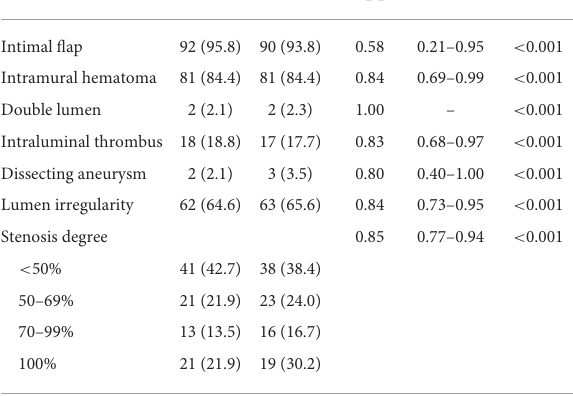
TABLE 3 The agreement between CDU and hrMRI